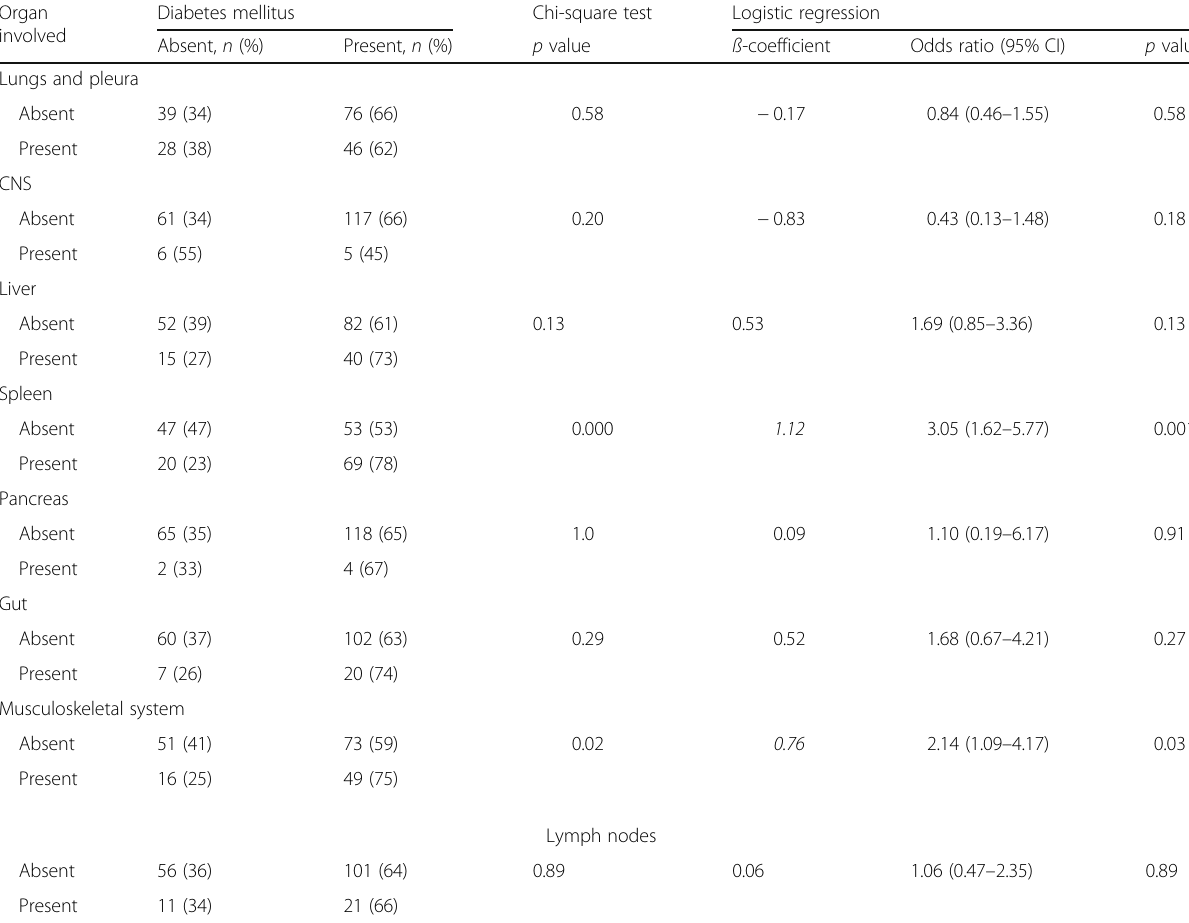
Table 3 Association of organ involvement in melioidosis with diabetes mellitus Organ Diabetes mellitus Chi-square involved